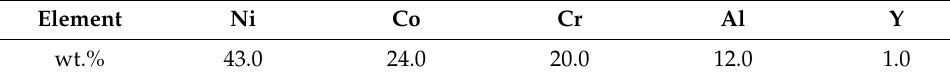
Table 1. C hemical composition of the Inconel 718 superalloy. Element Table 2. Chemical composition of the NiCoCrAlY powder. Table 2. C hemical composition of the NiCoCrAlY powder. Element